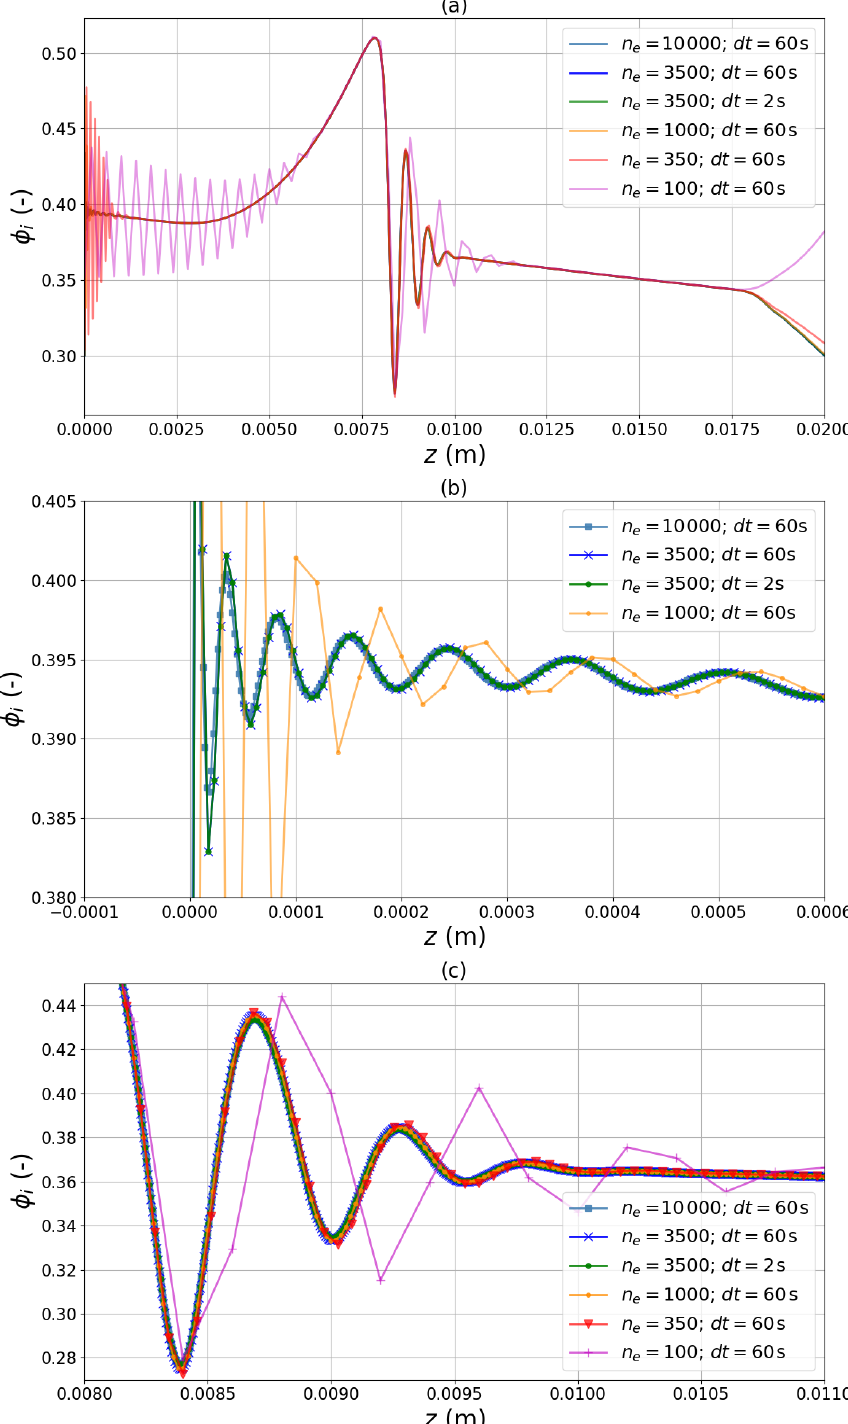
Figure 5. Sensitivity of the numerical solution to mesh resolution and time step size: (a) entire domain, (b) close-up of the left bound- ary region and (c) close-up of the sublimating (right) side of the Gaussian crust. Apart from the coarsest resolution, the lines are almost indistinguishable, indicating numerical convergence to the true solution.